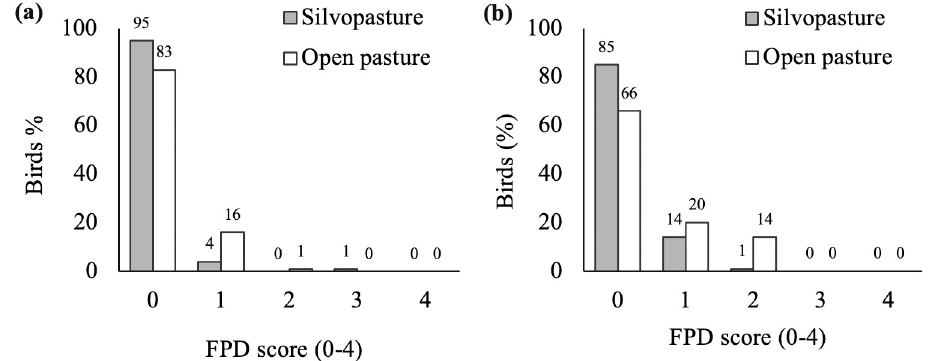
Fig 3. Percentage of birds with footpad dermatitis (FPD) scores 0–4 in the silvopasture and open pasture treatments. (a) On day 39 of age in Experiment 1 (n = 159). (b) On day 38 of age in Experiment 2 (n = 155).